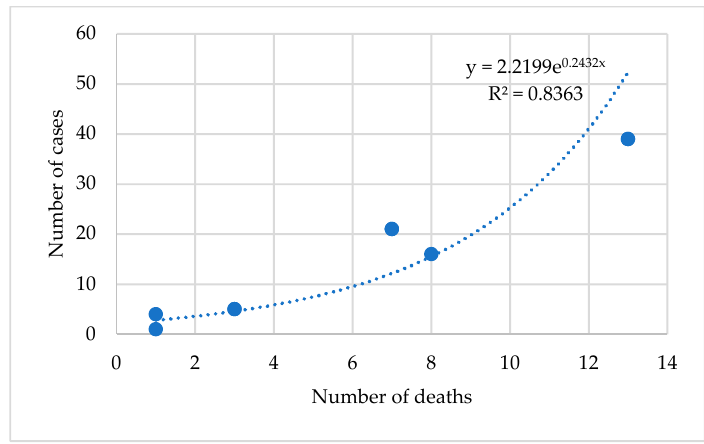
Figure 4. The association between the number of complications and the number of dead patients in the NRP+ group.